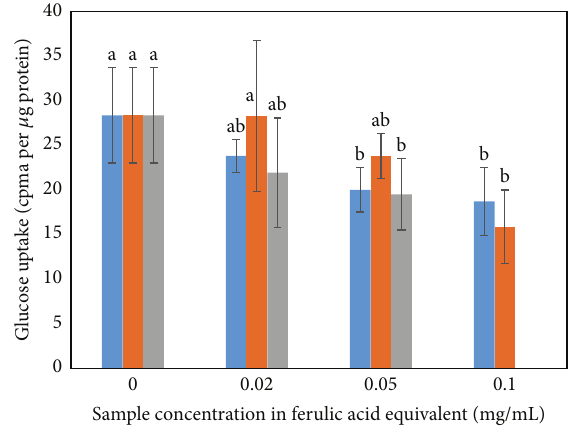
Figure 4: Effect of ferulic acid and feruloylated arabinoxylan mono- and oligosaccharides extracts on glucose uptake in Caco- 2 cells in sodium plus medium. Values are presented as mean ± standard deviation ( 𝑛 = 6). Data with the same superscript are not significantly different at 𝑝 ≤ 0.05 . FAXmo means feruloylated arabinoxylan mono- and oligosaccharide